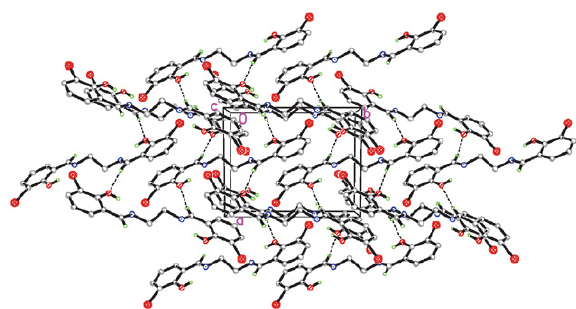
Fig. 2. Molecular packing diagram of H 2 L, viewed along the c axis. Hydrogen bonds are shown as dashed lines.